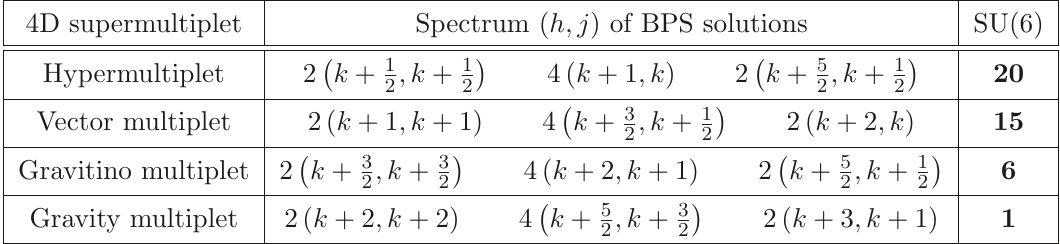
0. In each line the first entry is ≥